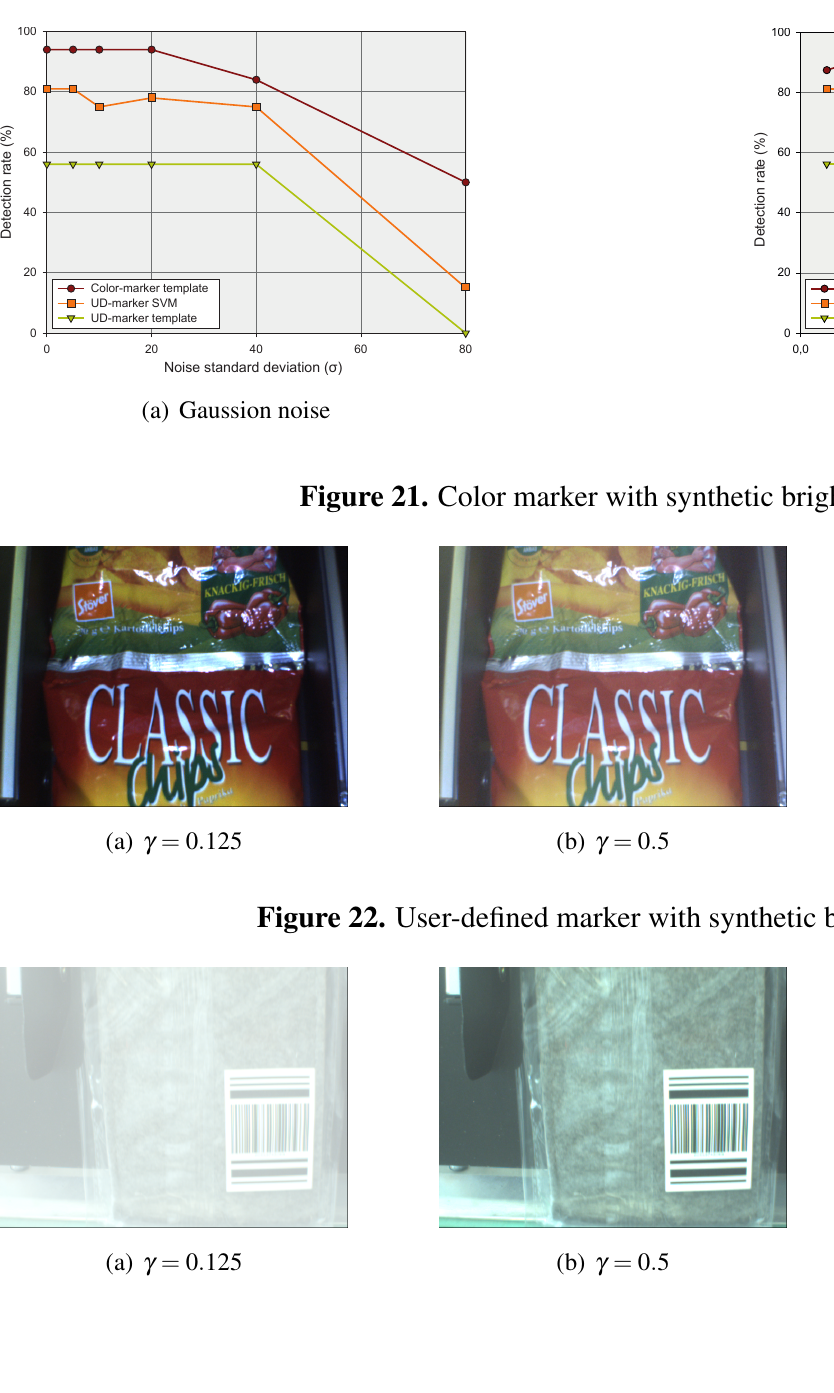
Figure 20. Evaluation of the robustness of the detection algorithm under varying ( a ) random Gaussian noise with standard deviation σ = 5;10;20;40;80 and ( b ) illumination conditions with γ = 0 . 125;0 . 25;0 . 5;1 . 5;2.